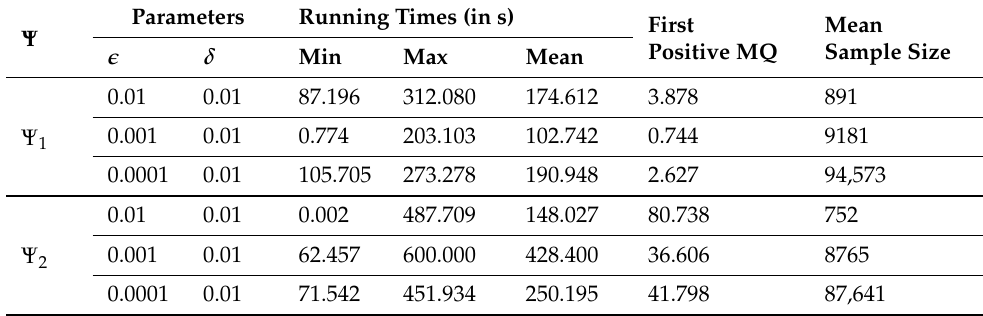
Table 9. E-commerce: On-the-fly verification of